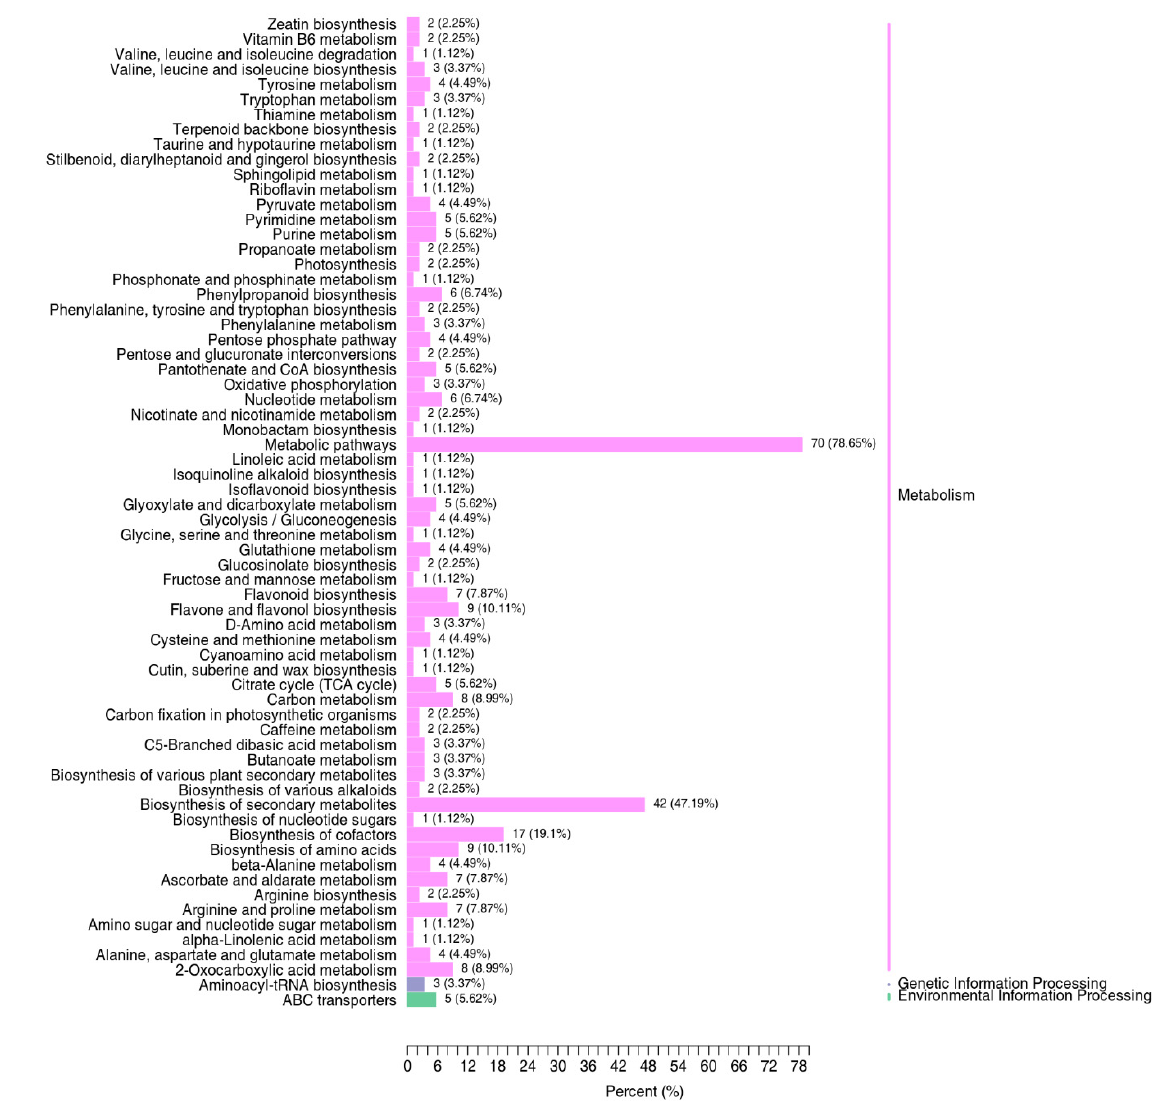
Figure 5. Summary of the different functions annotated for the differentially expressed metabolites (DEMs) using the KEGG database. Annotations revealed that the majority of the DEMs are involved in metabolic pathways and in the biosynthesis of secondary metabolites and cofactors. Note: A DEM can have multiple annotated functions.